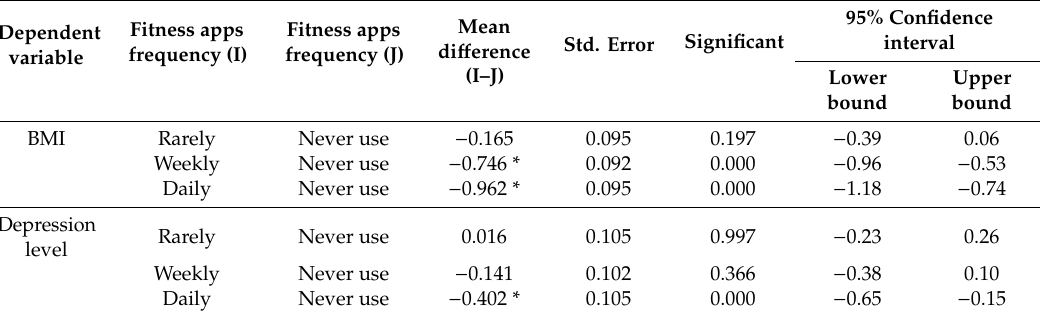
Table 5. Post Hoc Tests (Dunnet